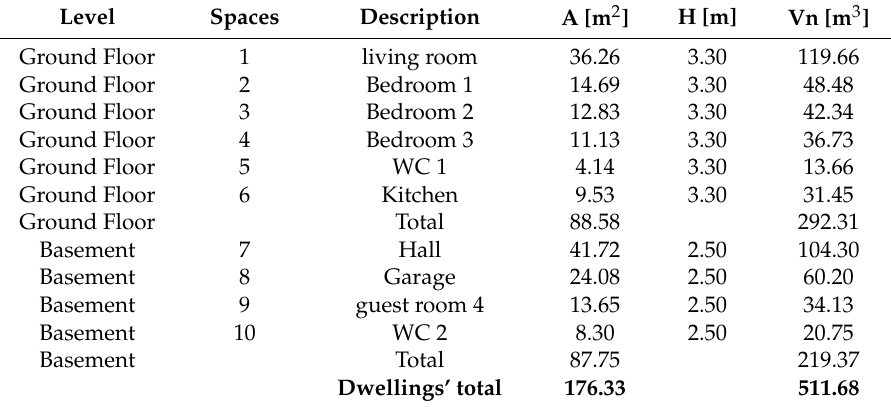
Figure 3. Level of examined buildings: ( a ) ground floor plan and ( b ) basement plan of each residential dwelling. Table 1. Geometrical data of the dwellings’ inner spaces.